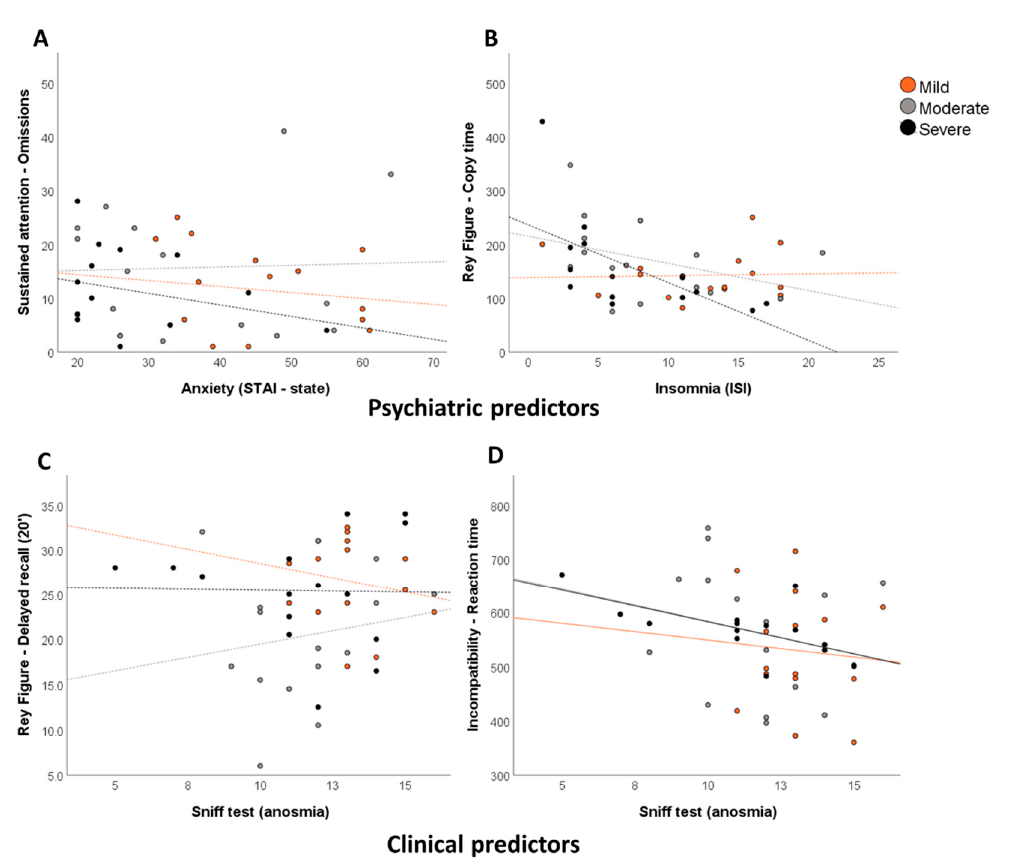
Figure: Rey–Osterrieth Complex Figure test [46]; RL/RI 16: free/cued recall 16 items (RL/RI 16) [44]; SD: standard deviation; STAI ‐ S: State–Trait Anxiety Inventory [60] STAI ‐ T: State–Trait Anxiety In ‐ ventory [60]; TAP: Test for Attentional Performance, Version 2.1 [43]; TMT: Trail Making Test; VOSP: Visual Object and Space Perception battery [49]; WAIS IV: Wechsler Adult Intelligence Scale– Fourth Edition [50].